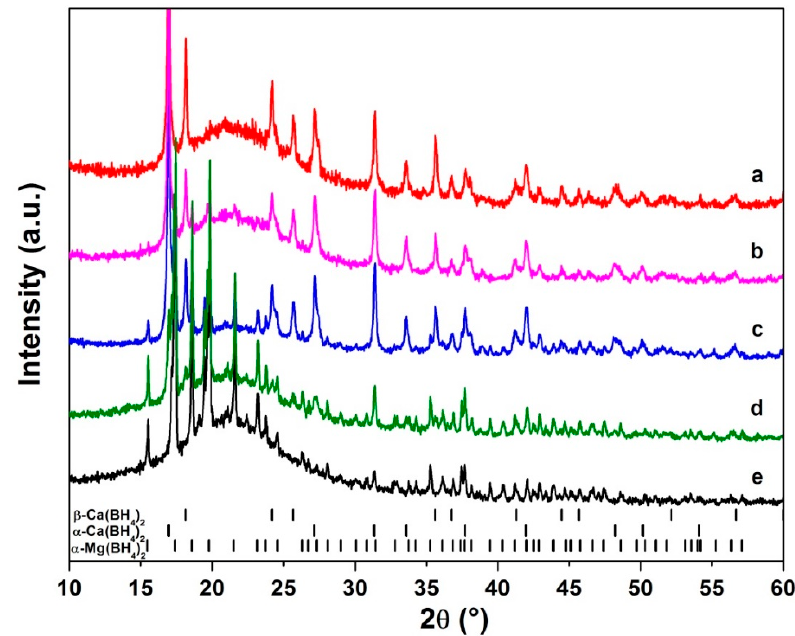
Figure 1. Powder X-ray diffraction (PXD) patterns of (a) Ca(BH 4 ) 2 , (b) 1Mg(BH 4 ) 2 : 2Ca(BH 4 ) 2 , (c) 1Mg(BH 4 ) 2 : 1Ca(BH 4 ) 2 , (d) 2Mg(BH 4 ) 2 : 1Ca(BH 4 ) 2 , and (e) Mg(BH 4 ) 2 after ball milling.